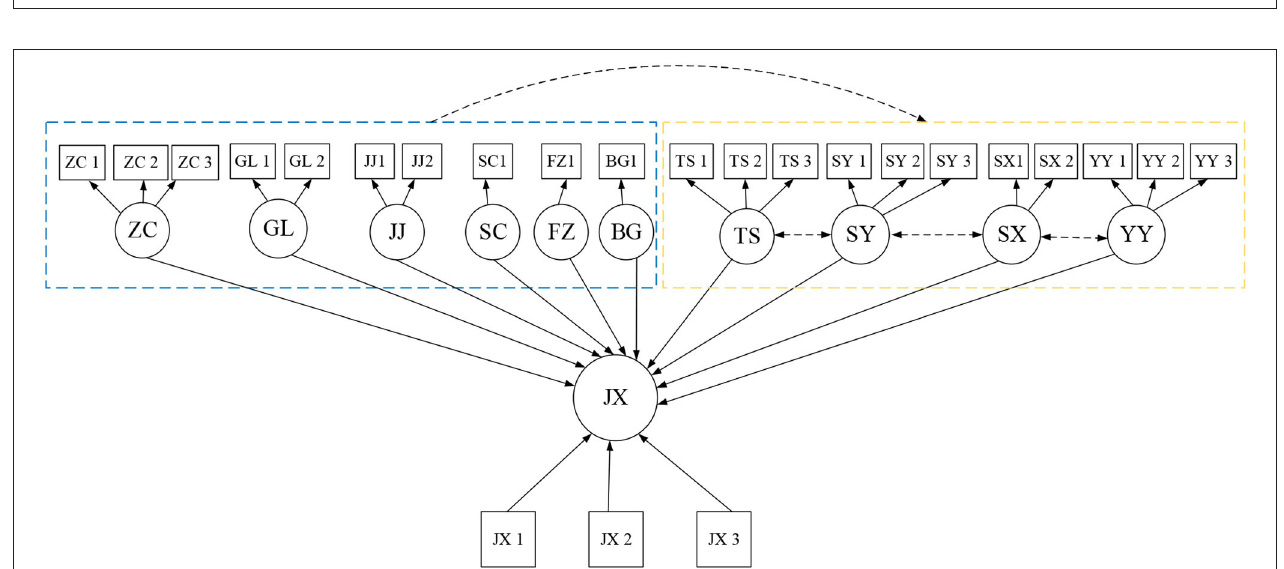
FIGURE 4 | Optimized